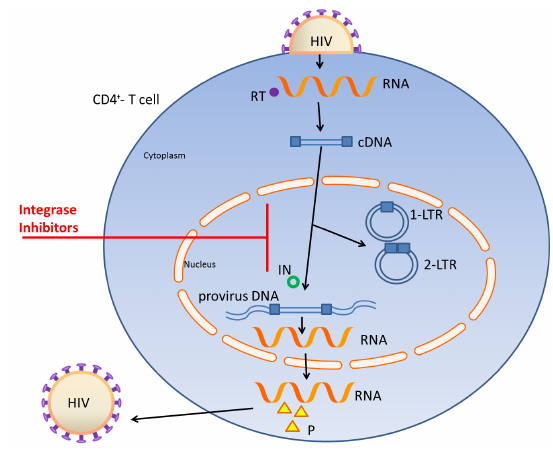
Fig. 6. Replication cycle-LTR circles.